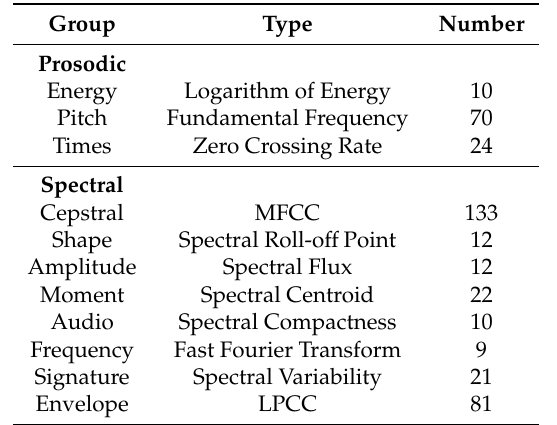
Table 3. List of 404 hybrid acoustic features (HAF) features [46].